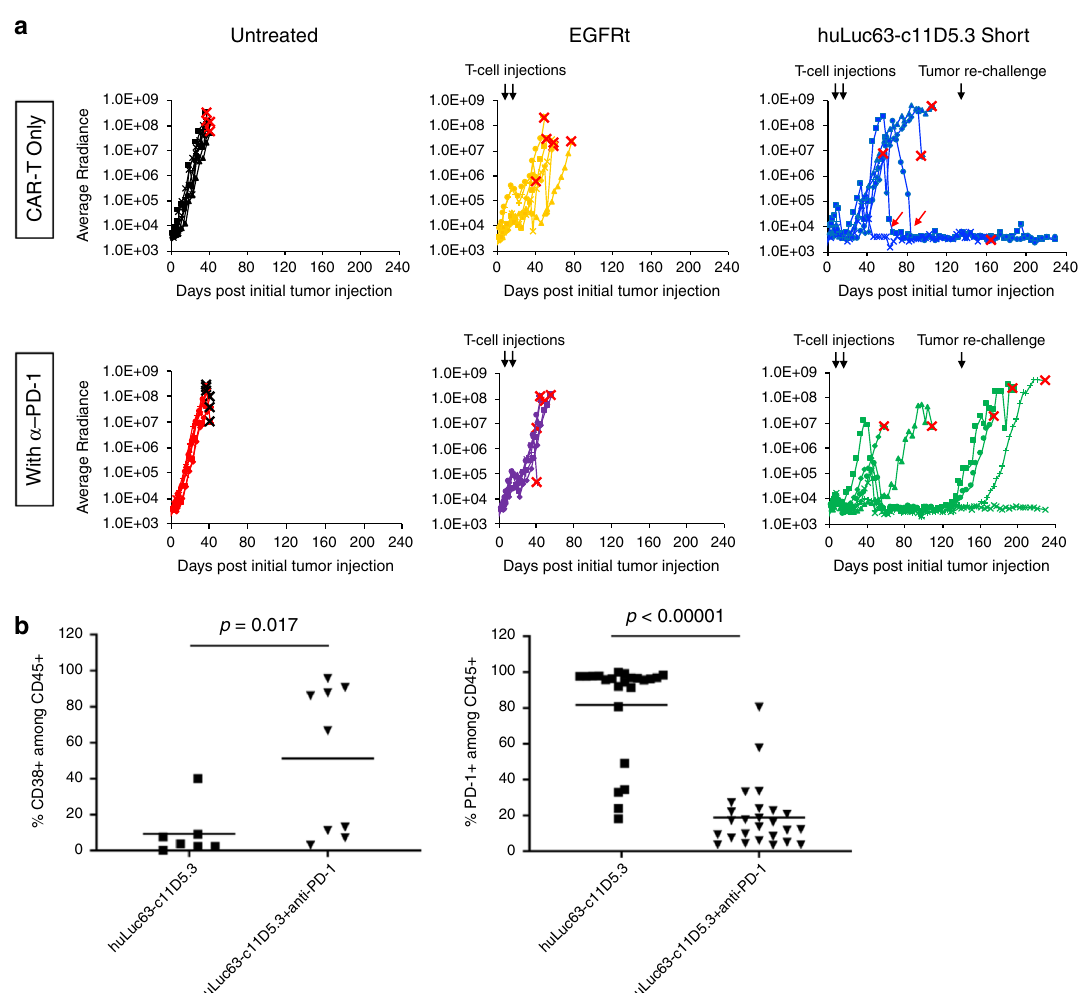
Fig. 5 Combination therapy with anti-PD-1 increases initial antitumor ef fi cacy but not durability of response in vivo. a Mice were engrafted with 1.5 × 10 6 WT MM.1 S cells. Tumor-bearing animals were treated with 1.5 × 10 6 EGFRt- or CAR-expressing T cells on day 8 (8 days after tumor injection) and day 16. Tumor progression was monitored by bioluminescence imaging and shown for individual animals in each test group ( n = 6). On day 133, animals that had been tumor-free for at least 7 weeks (3 each in the huLuc63-c11D5.3 Short groups with and without anti-PD-1) were rechallenged with 1.5 × 10 6 WT MM.1 S cells. Black arrows indicate time of cell injections; red arrows indicate instances of CAR-T cells eradicating palpable tumor nodules. The endpoint for each animal is marked with an “ X. ” b CD38 and PD-1 expression on T cells persisting in mice at time of animal sacri fi ce. Each data point in b corresponds to an individual tumor mass, tissue (e.g., brain and spleen), or cardiac blood sample recovered. For PD-1 expression: 23 samples were collected from six mice in the group not treated with anti-PD-1, and 26 samples were collected from six mice in the group treated with anti-PD-1. For CD38 expression: seven samples were collected from two mice in the group not treated with anti-PD-1, and nine samples were collected from three mice in the group treated with anti-PD-1. Only samples that contained at least 10 human CD45 + cells as detected by fl ow cytometry were included for analysis. P- values were calculated by unpaired two-tailed Student ’ s t -test. Source data are provided as a Source Data